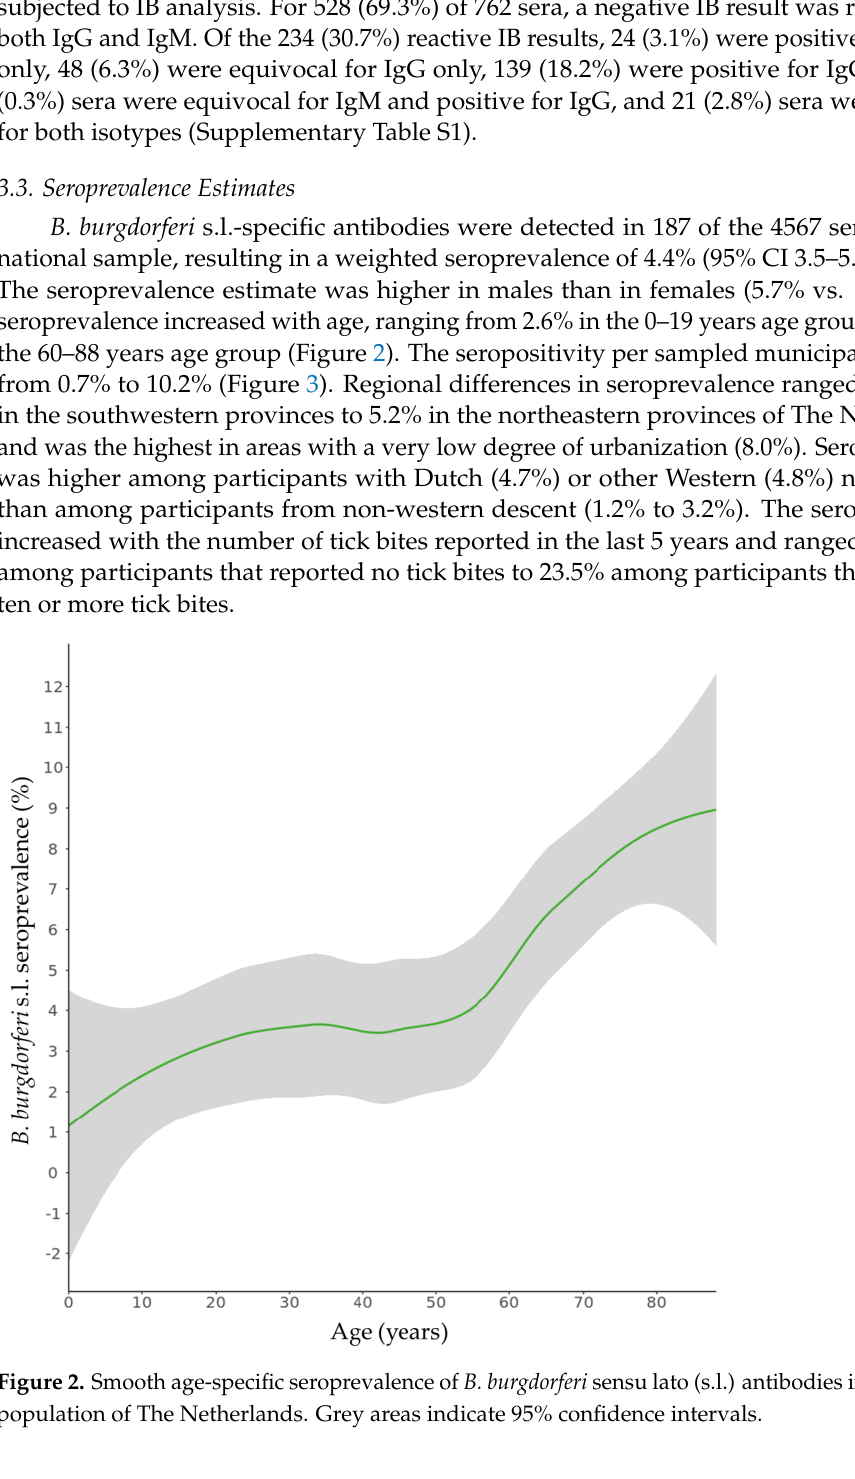
Figure 3. Lyme borreliosis seropositivity in the sampled municipalities in the Netherlands. Blue and orange boundaries indicate municipalities in the national sample and low vaccination coverage sample, respectively.